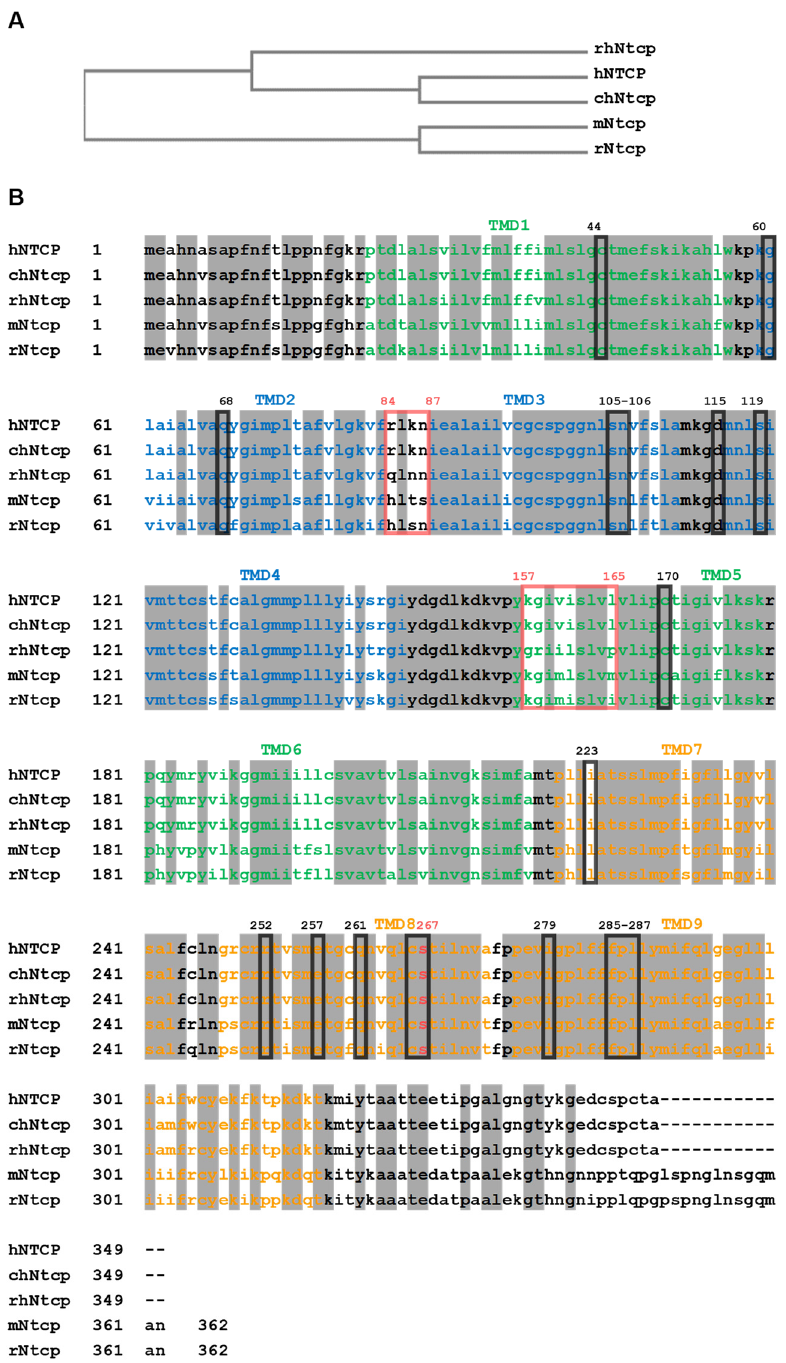
Figure 1. Multiple sequence alignment of NTCP/Ntcps from different species. ( A ) Phylogenetic relationship between human NTCP (hNTCP; Uniprot: Q14973), chimpanzee Ntcp (chNtcp; H2Q8J0), rhesus monkey Ntcp (rhNtcp; F6YRK3), rat Ntcp (rNtcp, Uniprot: P26435) and mouse Ntcp (mNtcp; Uniprot: O08705). ( B ) Deduced amino acid sequences from above-mentioned species were aligned using EBI ClustalW algorithm. Positions of transmembrane domains (TMD) are indicated with the color code also used in Figure 2. Identical amino acids among all species are marked with grey shading. The HBV/HDV preS1-peptide binding motifs of hNTCP 84 RLKN 87 and 157 KGIVISLVL 165 are marked with red boxes and amino acids regulating bile acid transport are labeled with black boxes. The highly conserved serine at position 267 that is relevant for bile acid binding and HBV/HDV infection is colored in red.